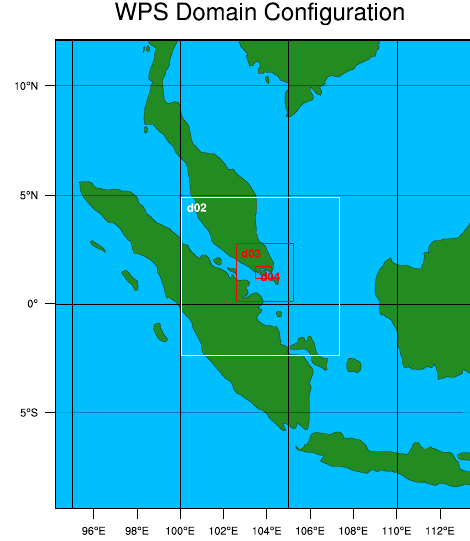
Figure 1. Nested computational domains for the WRF model set- up. d04 encompasses Singapore and surrounding areas of Malaysia and Indonesia.